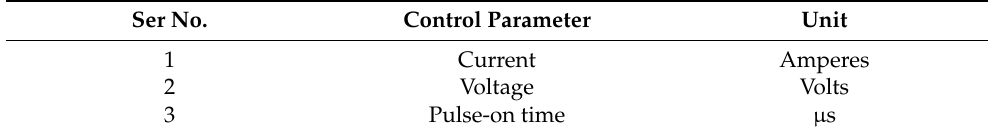
Table 3. WEDM controllable process